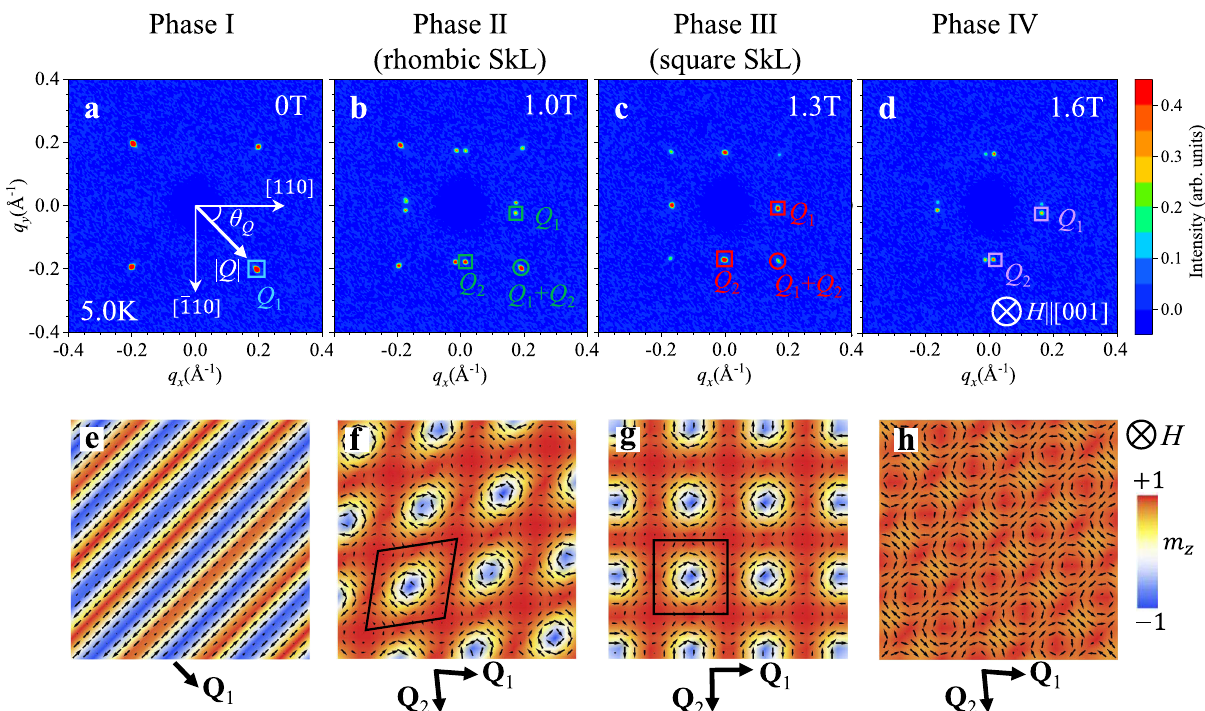
Fig. 2 Magnetic- fi eld dependence of SANS patterns for EuAl 4 . a – d Typical SANS patterns taken at 5.0 K at various strengths of magnetic fi eld for H || [001]. The color scale indicates the integrated intensity. e – h Schematics of the screw ( e ), rhombic skyrmion lattice ( f ), square skyrmion lattice ( g ), and vortex-lattice ( h ) spin textures. Each phase is characterized by distinctive orientation of the fundamental magnetic modulation vectors Q 1 and Q 2 . The rhombic and square skyrmion lattice states are the double- Q states described by Eq. (2), i.e., the superposition of two obliquely or orthogonally modulated spin helices. Background color represents the out-of-plane component of local magnetic moment m z . See Supplementary Note VII and VIII for the detailed spin texture in phase IV.